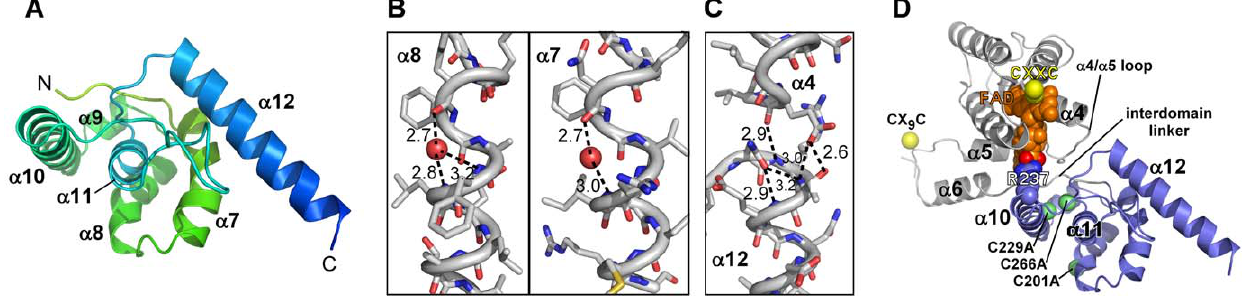
Figure 4. The R596-4C ORFan domain. (A) A single R596-4C ORFan domain is shown with secondary structure elements labeled. (B) Two irregular R596-4C ORFan domain helices with water-mediated i-to-i + 4 hydrogen bonding interactions. The water oxygen atom is shown at half its van der Waals radius. Dashed lines are labeled with distances (A˚ngstrom) between hydrogen bond donor and acceptor. (C) The carboxy-terminus of helix a 4 in the Erv domain caps helix a 12 in the ORFan domain. Inter- and intrahelical hydrogen bond donor-acceptor distances (A˚ngstrom) are indicated. (D) R596 interdomain interface. One subunit of R596-4C is shown with the Erv domain in gray and the ORFan domain in slate blue. C b atoms at sites of cysteine-to-alanine mutations are shown as lime-green spheres and marked by residue number. Extended segments of polypeptide sandwiched in the interdomain interface are labeled ( a 4/ a 5 loop and interdomain linker). The FAD is in orange, space-filling representation, with the O1P and O2P atoms distinguished in red. Arg237 from the ORFan domain, which approaches the FAD at O1P/O2P, is shown in space-filling representation. The lack of participation of helices in domain-domain packing is